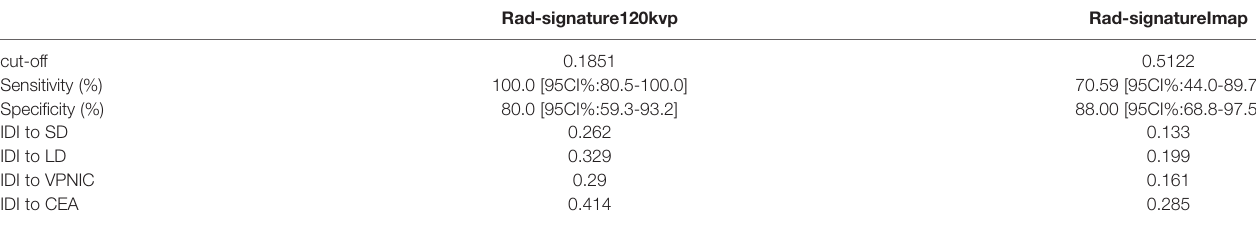
TABLE 5 | The cut-offs, sensitivities, speci fi cities and IDI index of two radiomics signatures in the testing group.